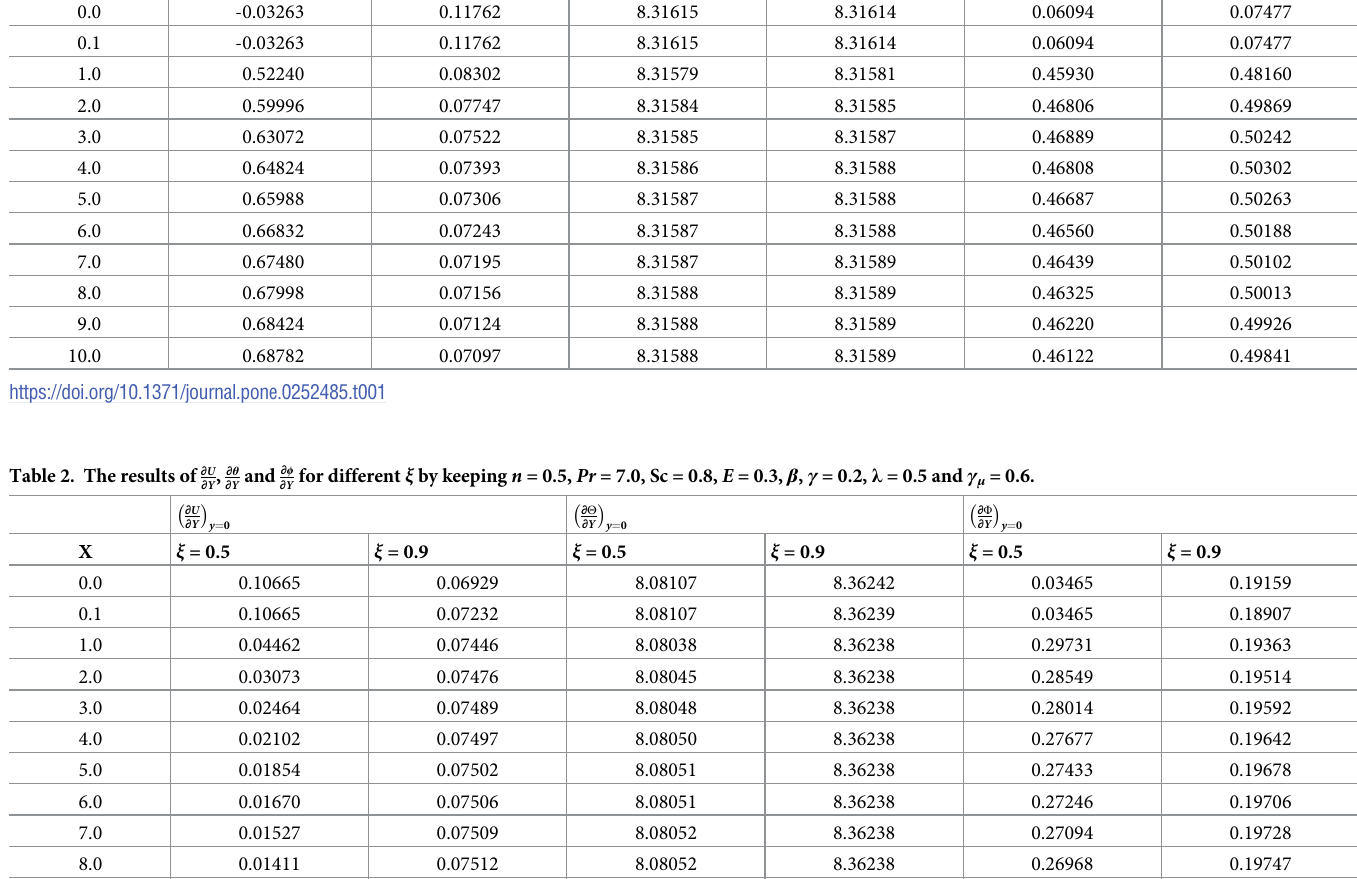
Table 1. The results of ∂ U